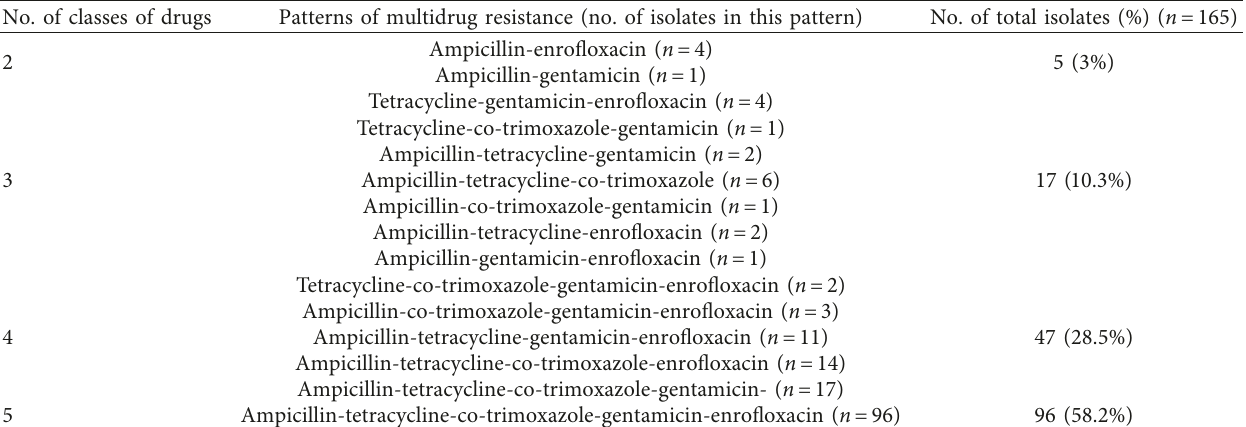
Table 2: The main phenotypic multidrug-resistant patterns of 165 E. coli strains were isolated from different livestock samples of the Emirate of Abu Dhabi.